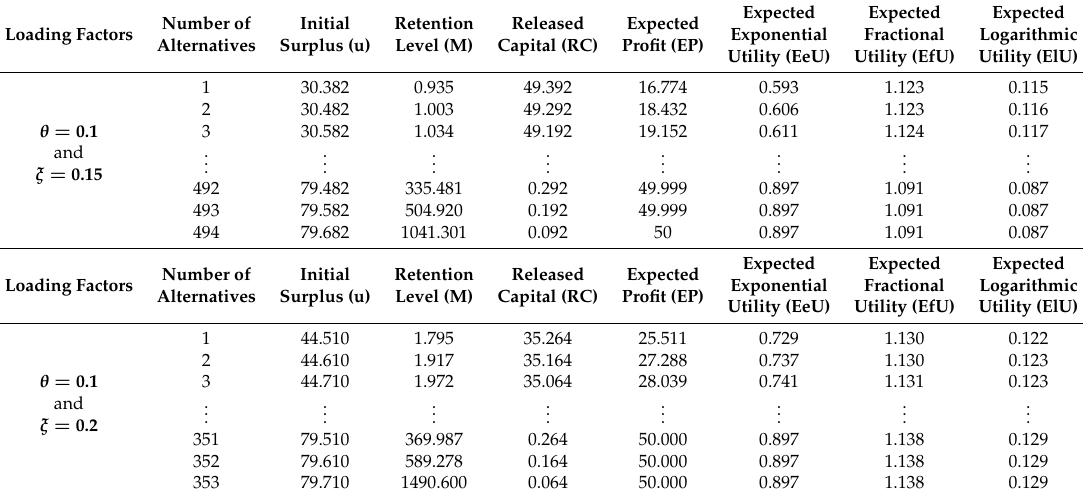
Table 7. Alternative sets for the Pareto claims under the excess of loss